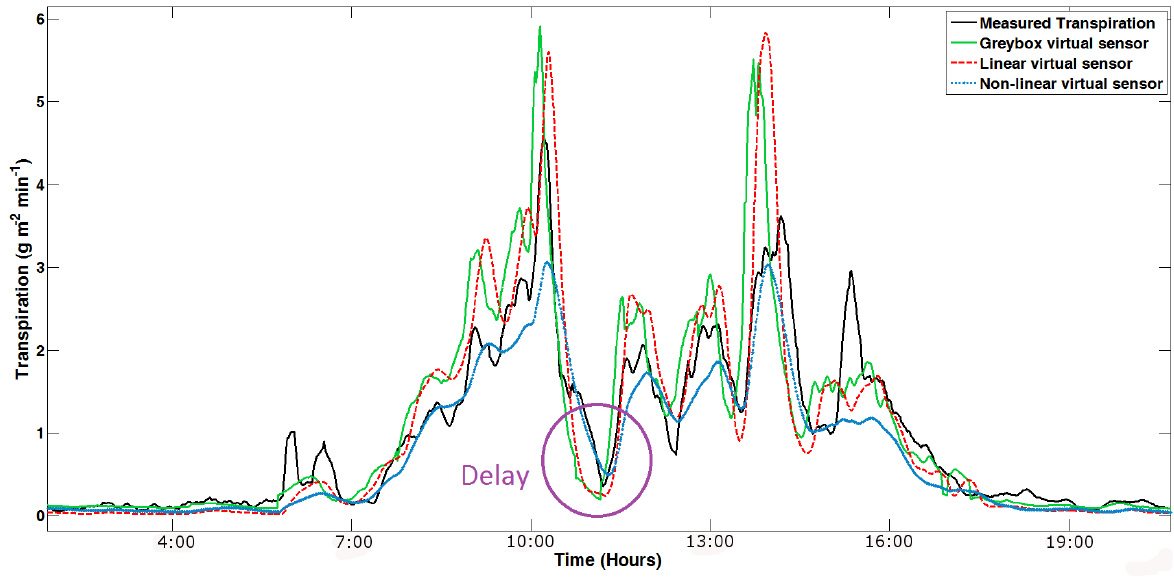
Figure 10. One full day with delay in the autumn–winter of 2007–2008. The figure starts at